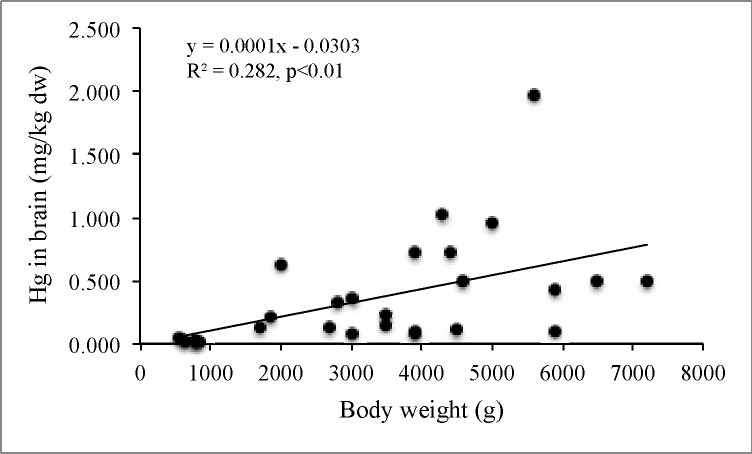
Analysis of data on raccoon, found frequently in the WMNP, shows a significant relationship between brain Hg levels and body weight in this partly piscivorous species.